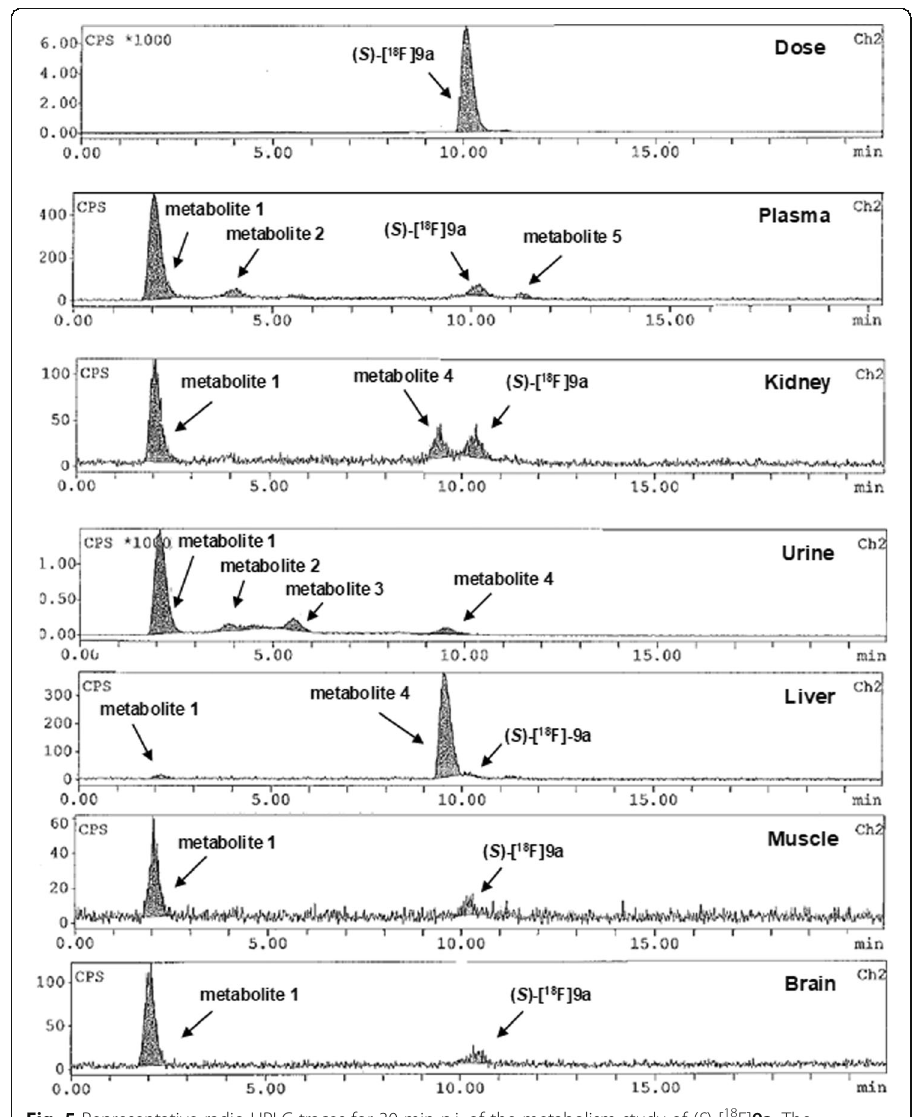
Fig. 5 Representative radio-HPLC traces for 30 min p.i. of the metabolism study of ( S )-[ 18 F] 9a . The radiochemical purity of ( S )-[ 18 F] 9a was > 97% before injection. The samples were analyzed by HPLC, using a γ -detector (Raytest Isotopenmessgeräte GmbH/Agilent). The HPLC was done on a Phenomenex C18 column (250 × 4.6 mm) using a gradient method with acetonitrile and water (both having 0.05% TFA)